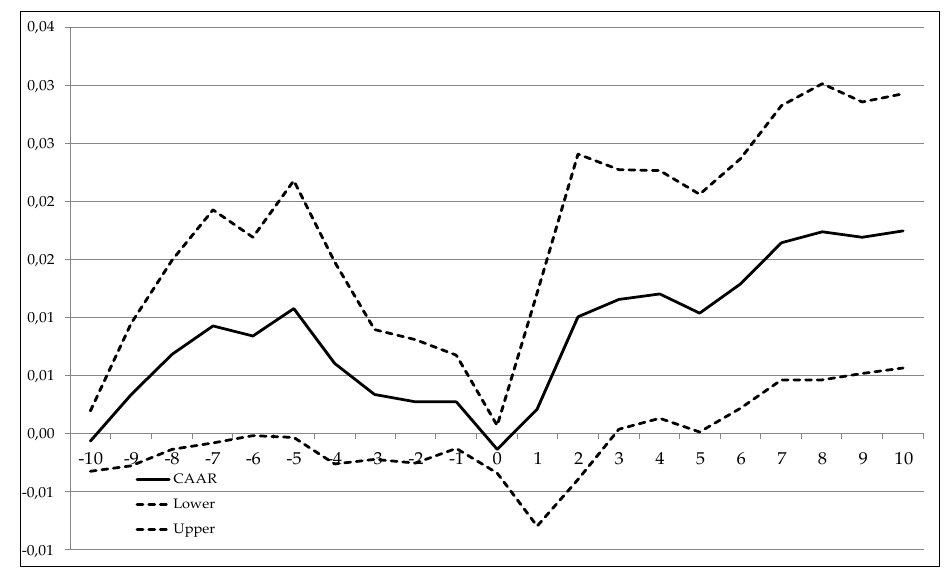
Figure 2. CAR τ for all markets, SEE regional market factor, with 95% CIs. Figure 2. τ CAR for all markets, SEE regional market factor, with 95% CIs. Table 3. Volatility reaction results to Brexit.